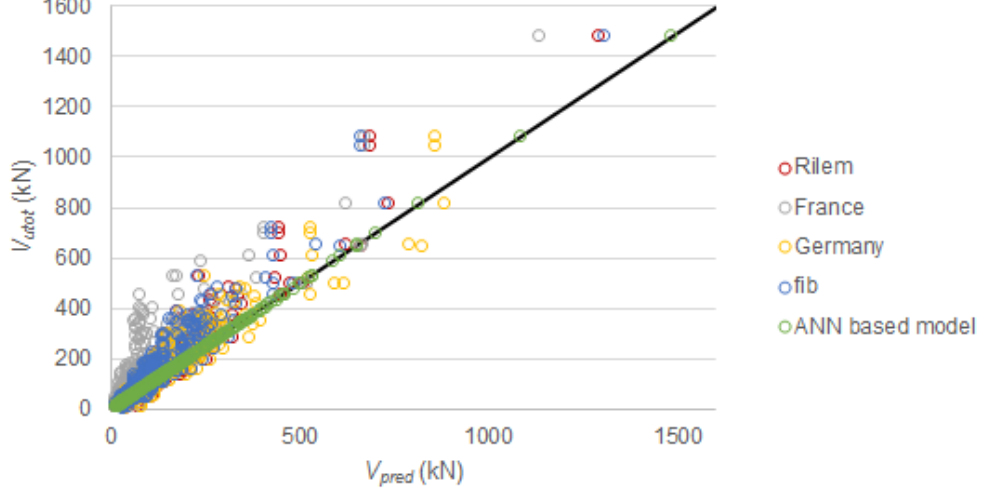
Figure 8. Comparison between ANN-based model and existing methods proposed in the literature.